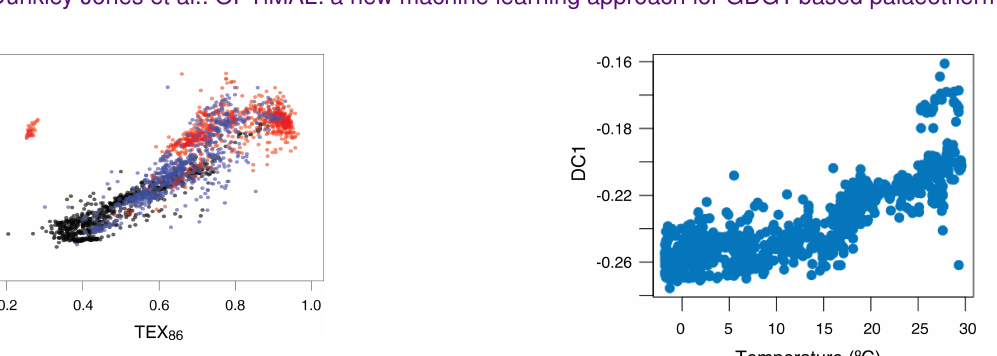
Figure 8. The first diffusion component as a function of TEX 86 . Some outlying points have been excluded from the plot for the pur- poses of visualisation. Black: modern; blue: Eocene (Inglis et al., 2015); red: Cretaceous (O’Brien et al., 2017).